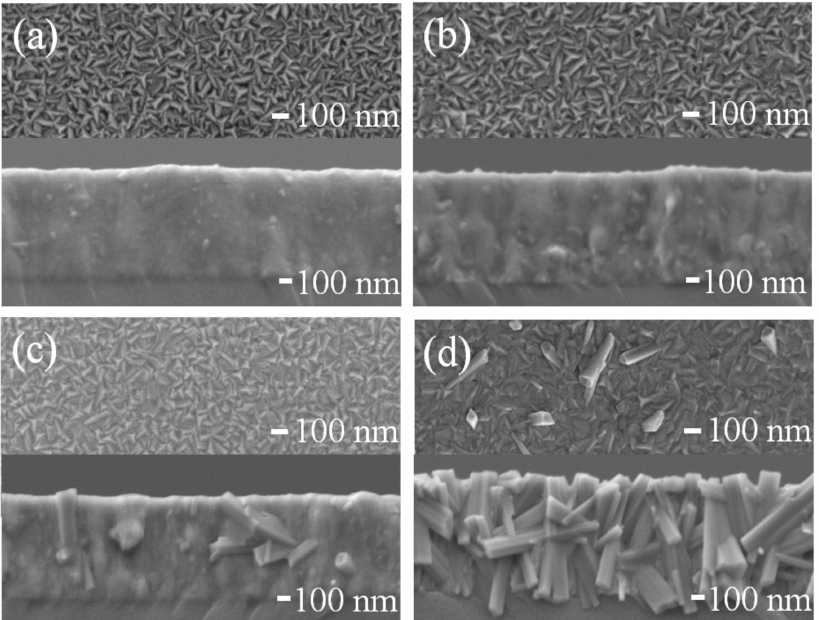
Figure 7. SEM to observe the surface morphology and cross-section of Mo films fabricated using HiPIMS with different bias voltage: ( a ) floating; ( b ) − 20 V; ( c ) − 40 V; ( d ) − 60 V.